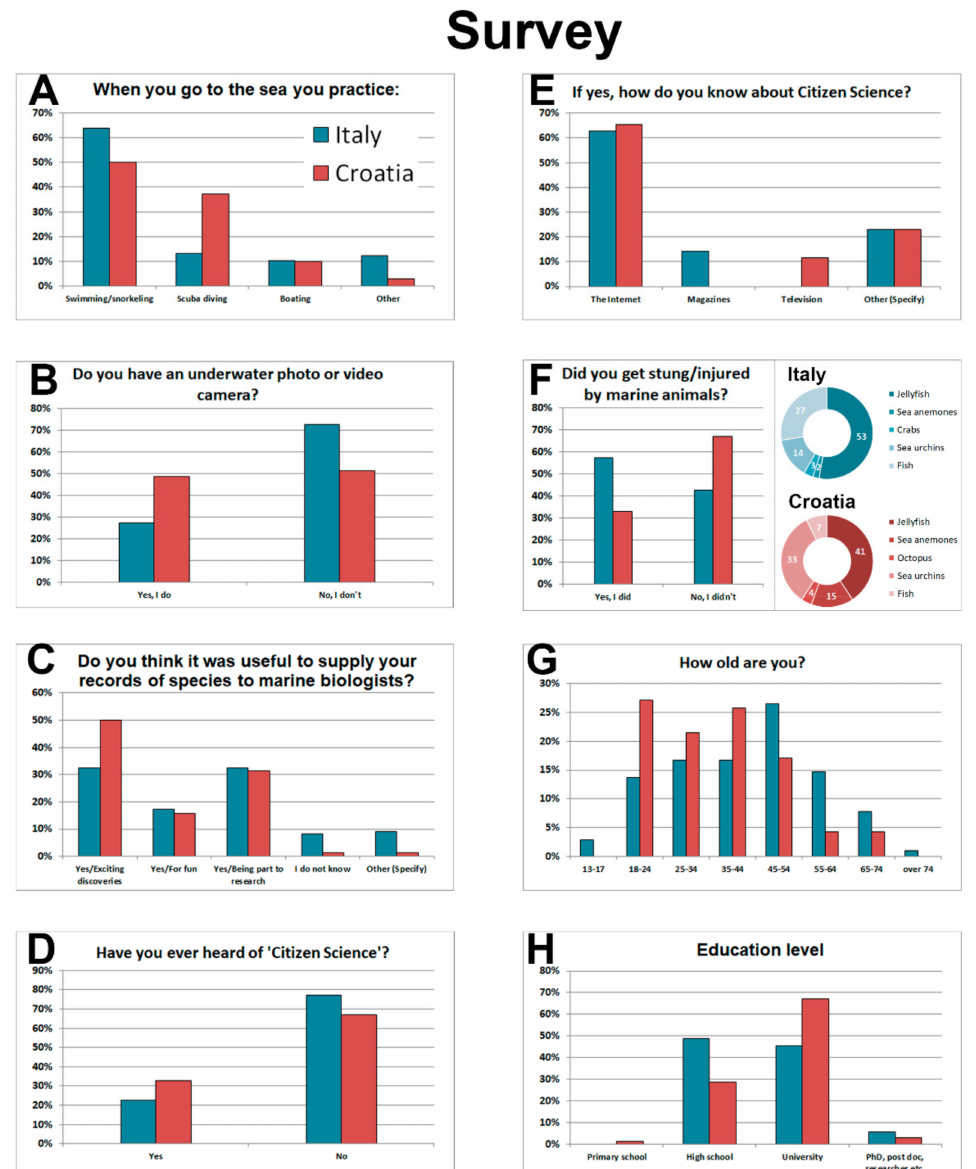
Figure 6. Survey questionnaire. Titles of histograms from ( A – H ) correspond to the questions of the survey; while, on the x-axis are indicated the possible choices, and on the y-axis there are the response percentages. Results of the survey from the participants from Italy are shown in blue; while, those relative to participants from Croatia are in